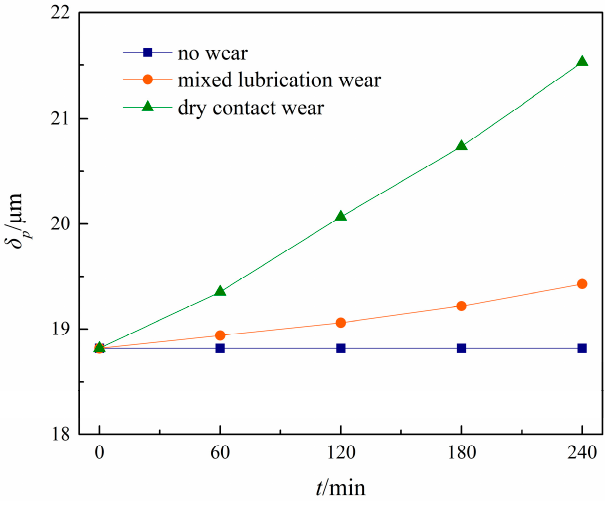
Figure 11. Variation of the δ p.